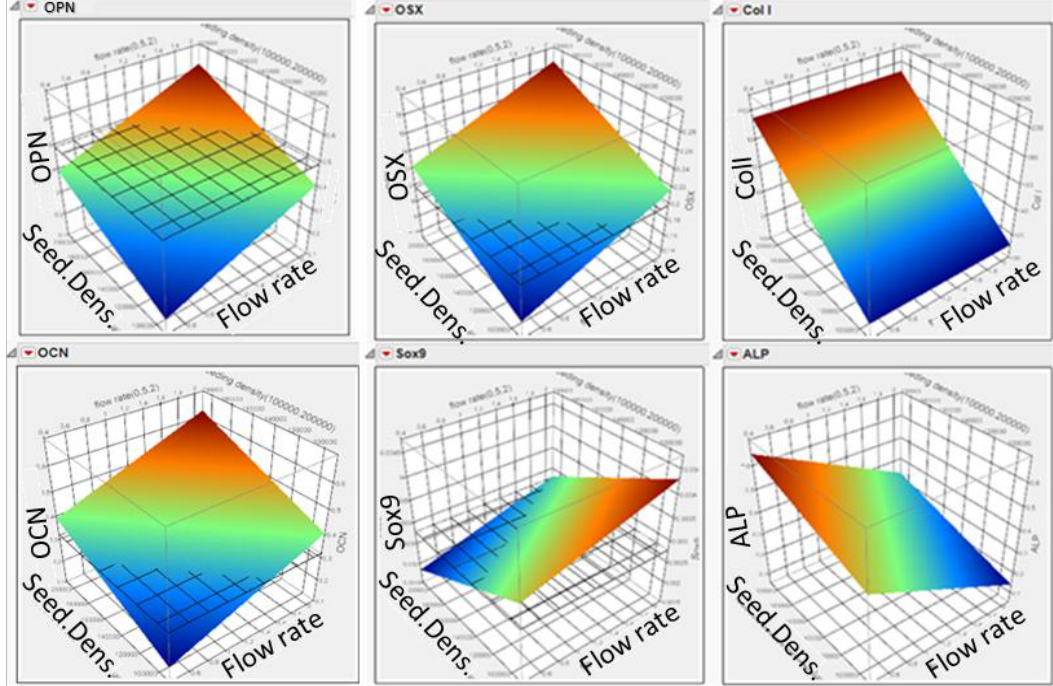
Figure 7. Response surface representations showing the effect of seeding density (Seed. Dens.) and flow rate on gene expression levels for all genes studied. Relative expression levels were used to plot the response surfaces shown. The data shown are indicative of Day